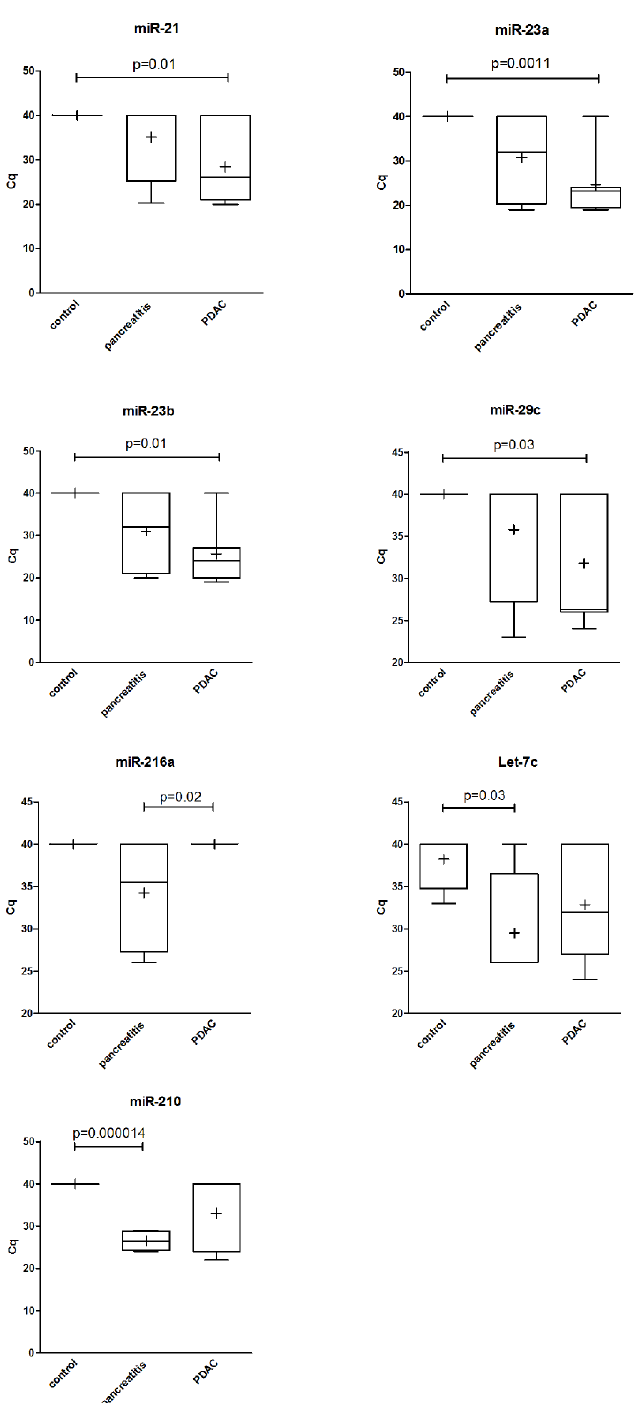
Fig 1. Analysis of candidate miRNAs expression (Cq) in the saliva of patients with unresectable pancreatic cancer (n = 7), pancreatitis (n = 4) or cancer-free patients (n = 4). Results are presented as Whiskers box (min-max) and mean (+) is indicated. The p value (nonparametric Wilcoxon rank-sum test) is indicated.